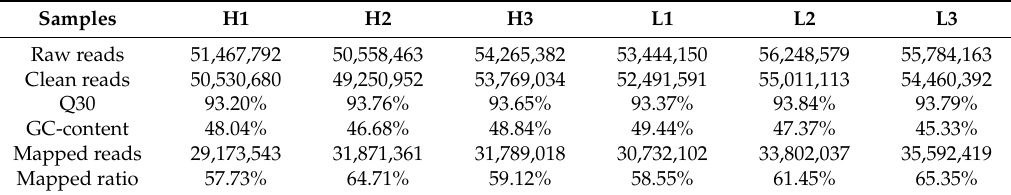
Table 1. Overview of the sequencing